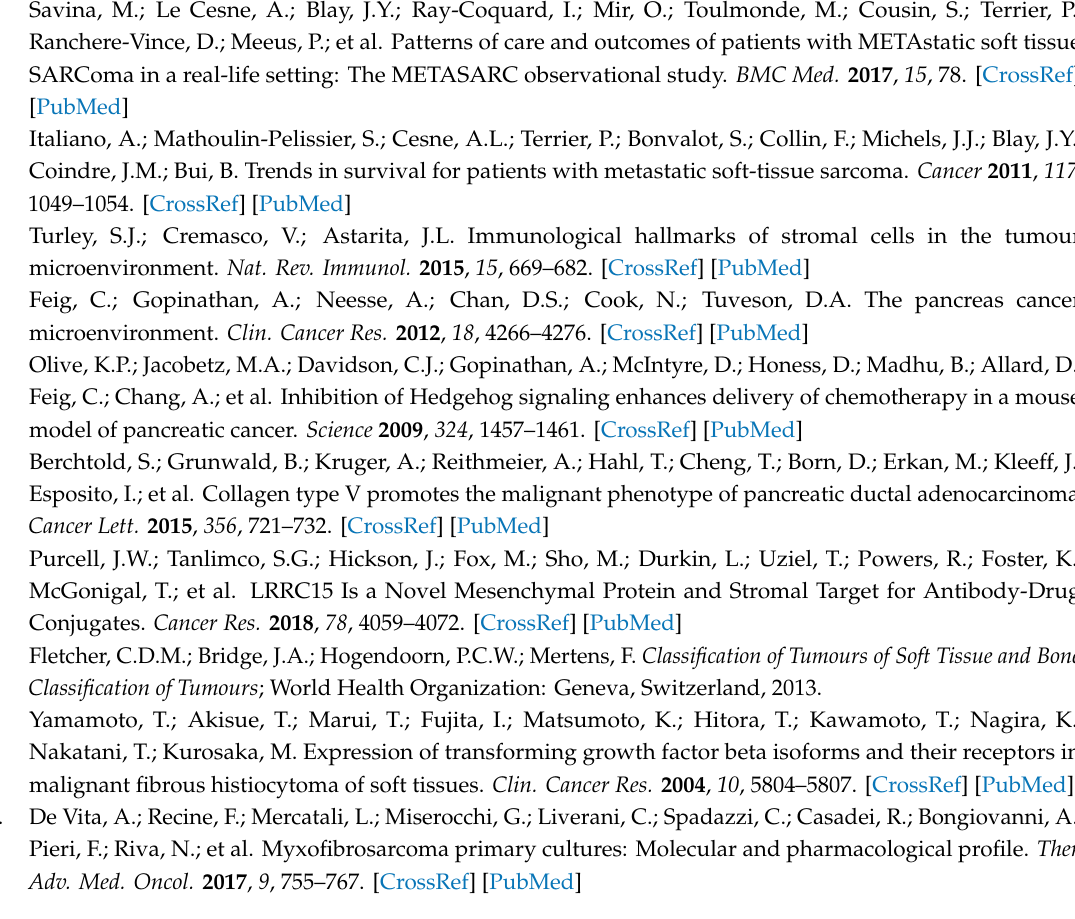
Figure S1: Preclinical activity of ABBV-085 in LRRC15-positive UPS patient derived xenograft models, Figure S2: Immunohistostaining of macrophages (F4 / 80) on PDX JR588 para ffi n slices of treated mouse by (A) Vehicle, (B) Isotype ADC, (C) ABBV-085 antibody, Figure S3: LRRC15 expression on PDX JR588 para ffi n slices of treated mouse by (A) ABBV-085, (B) Vehicle (C) Isotype. Table S1: LRRC15 expression according to